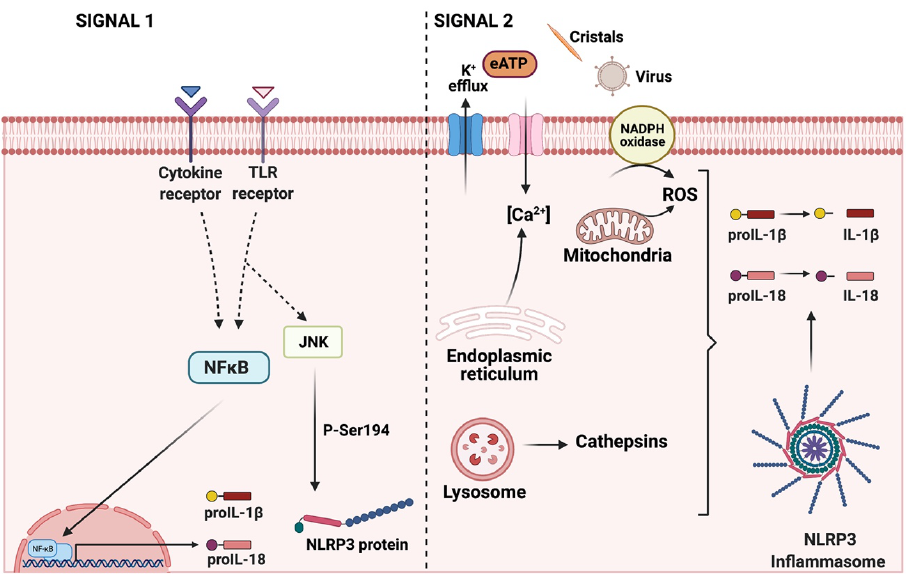
Figure 3. Activation of the NLRP3 inflammasome signaling pathway requires two signals. The signal 1 or priming (left) is provided by the activation of TLRs or cytokine receptors, leading to the NF- κ B activation that upregulates the levels of several inflammasome components such as the protein NLRP3, proIL-1 β and proIL-18. In addition, during the priming step, JNK-mediated phosphorylation occurs at S194 of NLRP3. Signal 2 or activation (right) is provided by any of numerous PAMPs or DAMPs including virus, cholesterol, potassium efflux, reactive oxygen species (ROS), extracellular ATP and lysosomal dysfunction, among others. ASC, an adaptor protein, recruits NLRP3 and procaspase-1 to form the NLRP3 inflammasome complex. Caspase 1 promotes the processing of interleukins for its subsequent